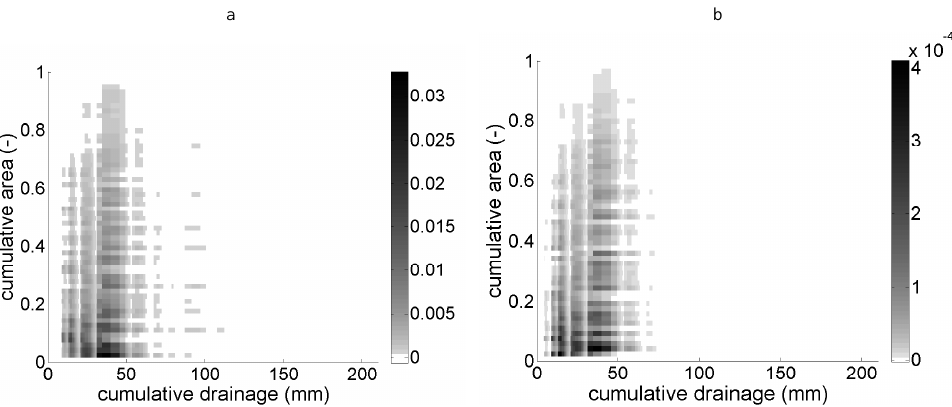
Fig. 10. Scaled solute flux density (d − 1 ) from simulations, at 0.5m depth, for the year 1997 without snowmelt. (a) Tracer, (b) degradable solute (half-life time τ =